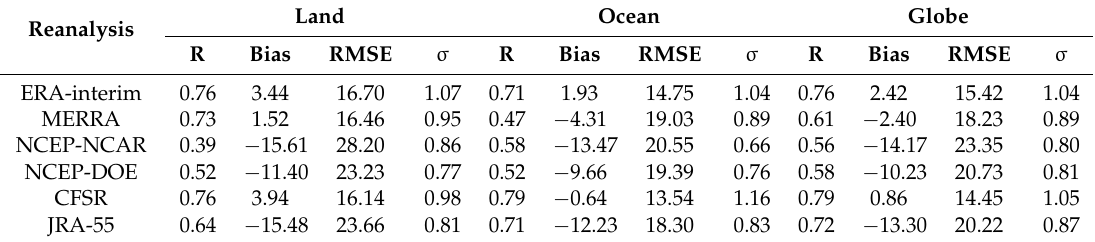
Table 8. Evaluation of monthly cloud fraction (CF) from global reanalyses using CERES MODIS observed CF data from 2001 to 2009 at 1 ˝ ˆ 1 ˝ grid scale over land, the oceans, and the globe. Reanalysis